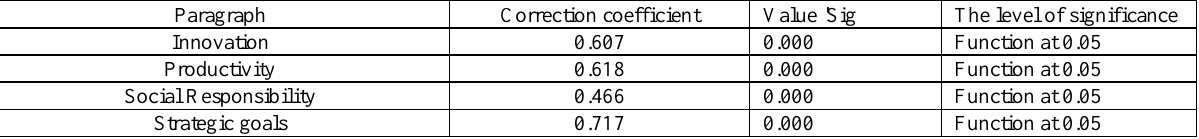
Table 17. Person's correlation transactions between human resources and strategic goals Paragraph Correction coefficient Value 'Sig The level of significance Innovation Strategic goals Function at 0.05